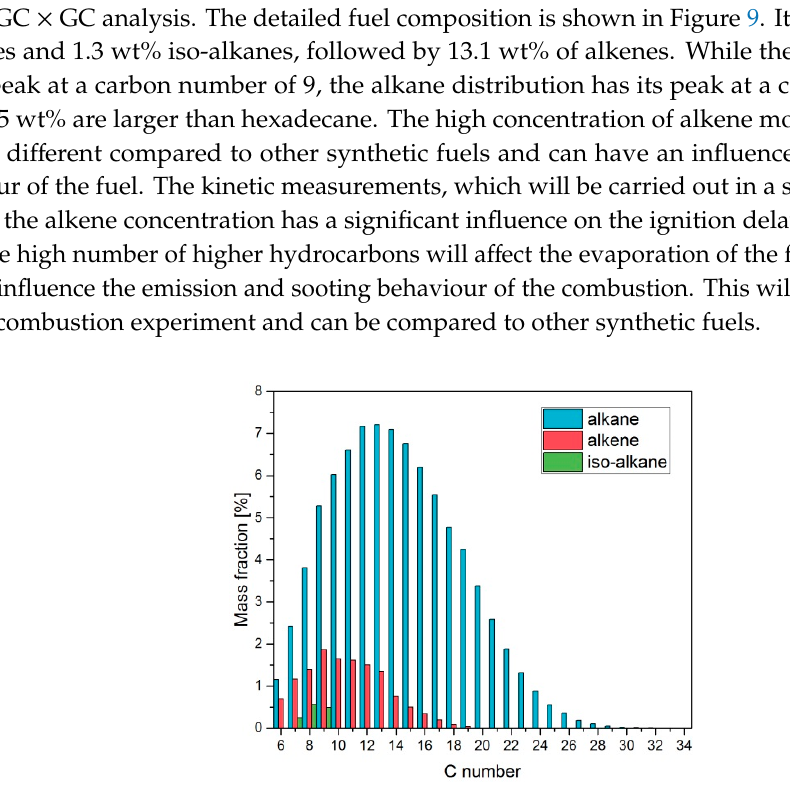
Figure 9. Detailed fuel composition of the liquid phase intermediate in the Fischer–Tropsch process.